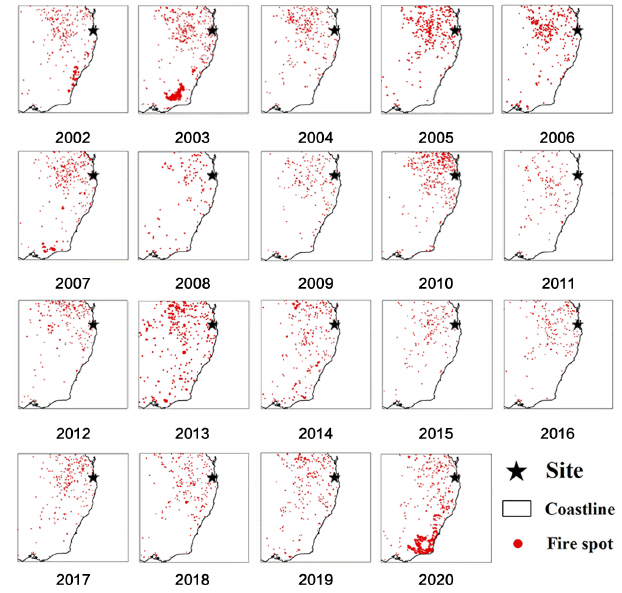
Figure 6. The fire spot distribution in eastern Australia during Jan- uary from 2002 to 2020.